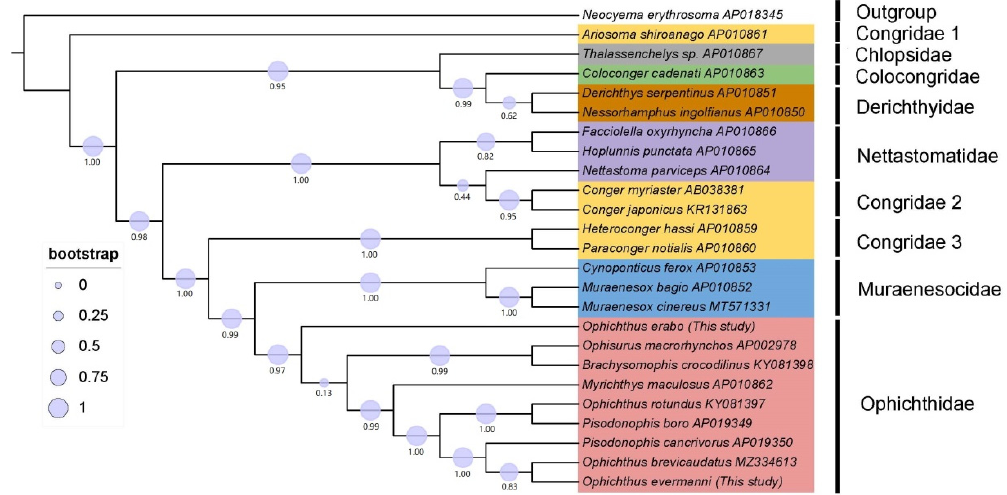
Figure 3. Phylogenetic tree of 25 Anguilliformes species constructed by Maximum Likelihood (ML) method based on concatenated sequences of 12 PCGs.